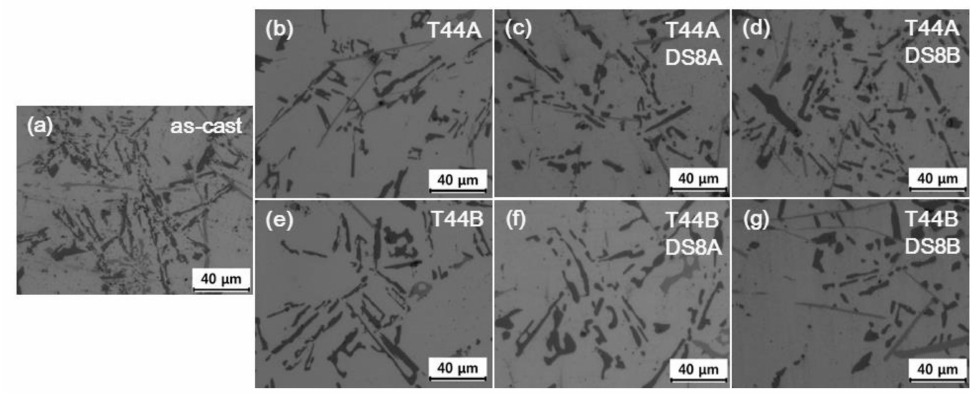
Figure 6. Microstructure of the Al6Si2Cu alloys after different solution treatments: ( a ) as-cast;